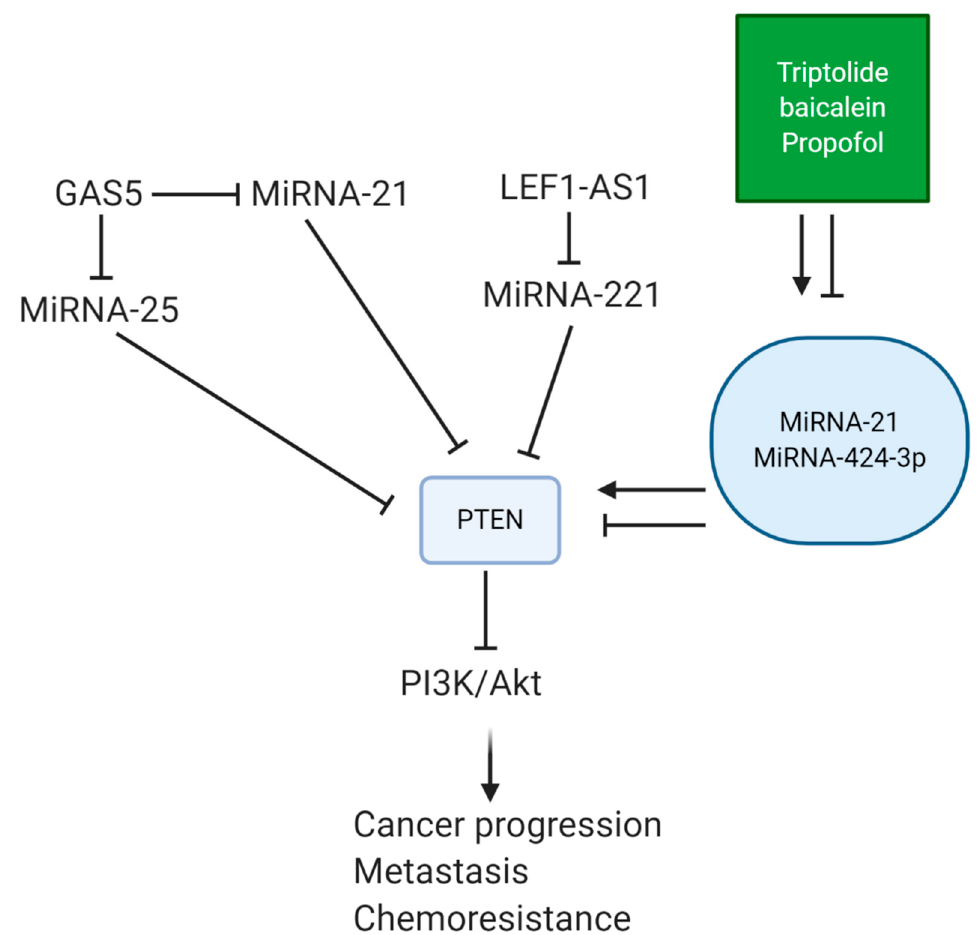
Figure 5. Similar to breast cancer, anti-tumor compounds and lncRNAs can regulate the miRNA/PTEN axis in affecting the progression of lung cancer cells.